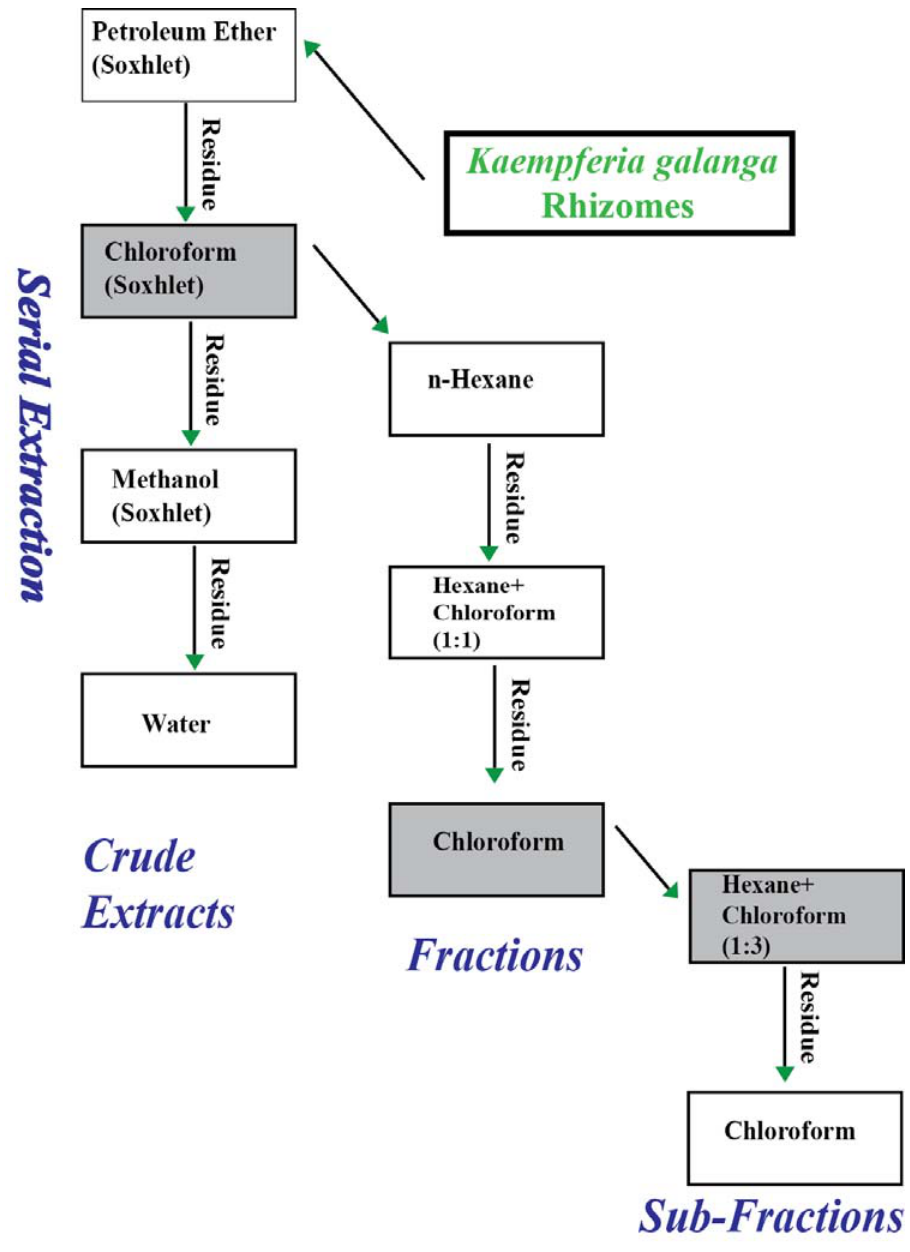
Figure 6. Schematic diagram showing the sequential extraction, fractionation and sub-fractionation of the dried rhizomes of Kaempferia galanga. Gray boxes represent the extract, fraction, and sub-fractions with maximum inhibition of rat paw